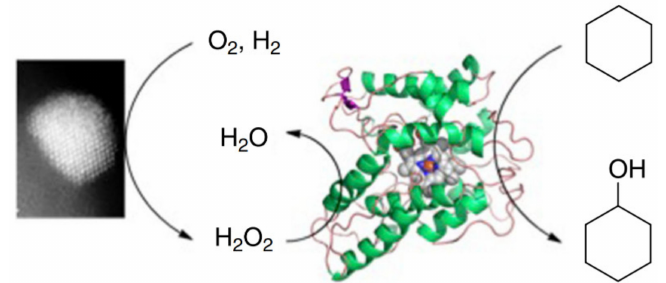
Figure 10. Chemoenzymatic cascade for selective oxidation of cyclohexane using in situ produced H 2 O 2 . Figure adapted from Ref.